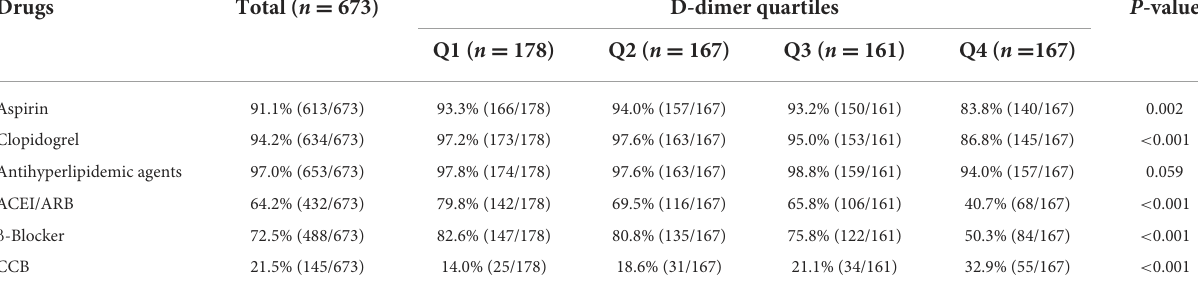
TABLE 2 Medication status of patients with NSTEMI.